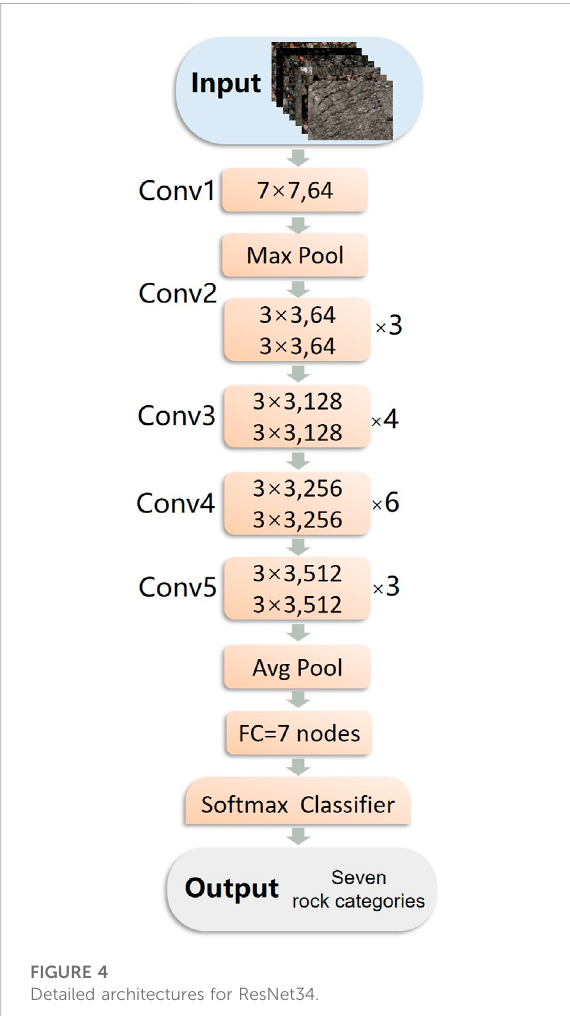
FIGURE 4 Detailed architectures for